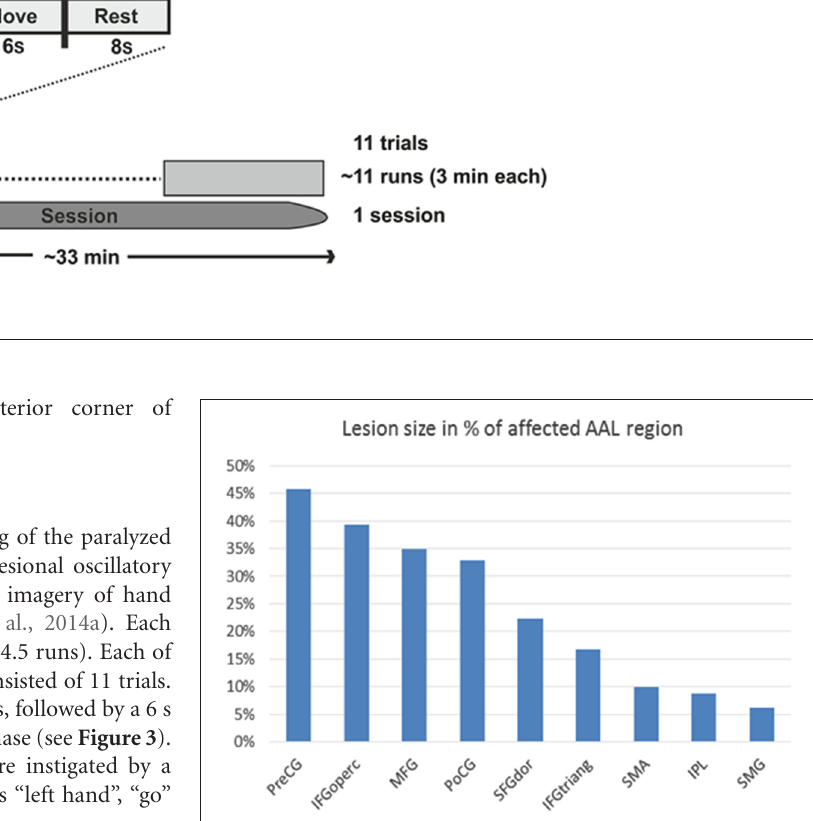
FIGURE 3 | Lesion size in percentage of affected cortical AAL (=automated anatomical labeling) region (Tzourio-Mazoyer et al., 2002): Affected cortical regions are named according to the AAL brain atlas labels: PreCG = precentral gyrus, IFGoperc = pars opercularis of inferior frontal gyrus, MFG = middle frontal gyrus, PoCG = postcentral gyrus, SFGdor = superior frontal gyrus, dorsolateral, IFGtriang = pars triangularis of inferior frontal gyrus, SMA = supplementary motor area, IPL = inferior parietal lobule, SMG = supramarginal gyrus